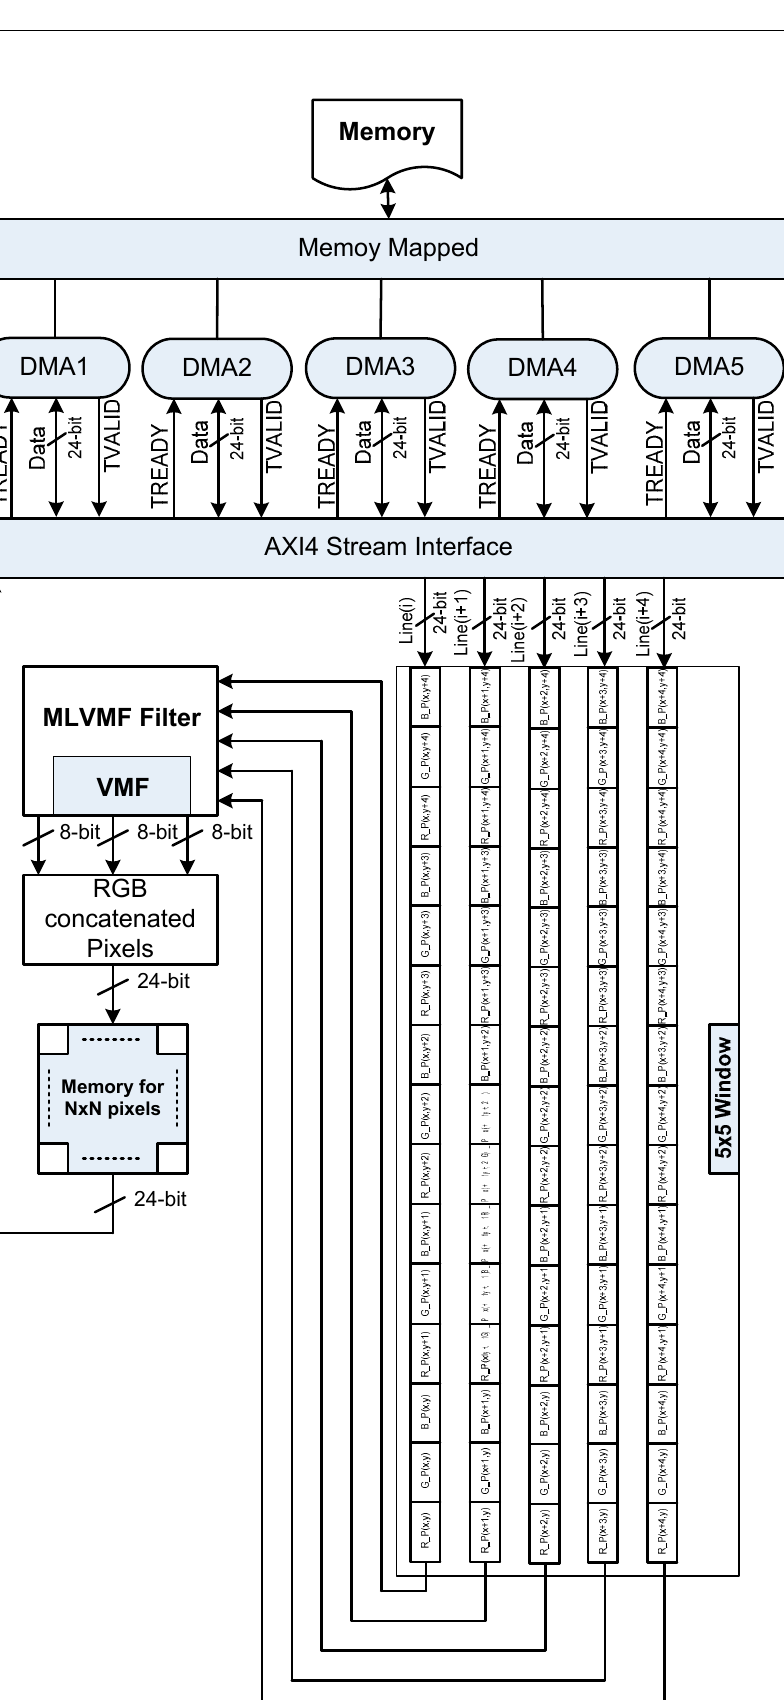
Figure 8. Proposed MLVMF filter block diagram.